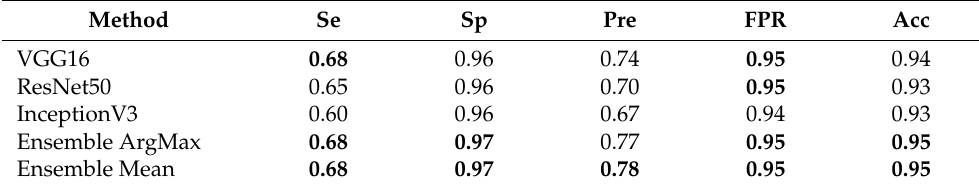
Table 6. Performance parameters for the different classifiers with the previous segmentation of the image with a SegNet when classifying BCC vs. All lesions. Se: Sensitivity, Sp: Specificity, Pre: Precision, FPR: False Positive Rate, Acc: Accuracy. The highest values are shown in bold numbers. Method Se Sp Pre